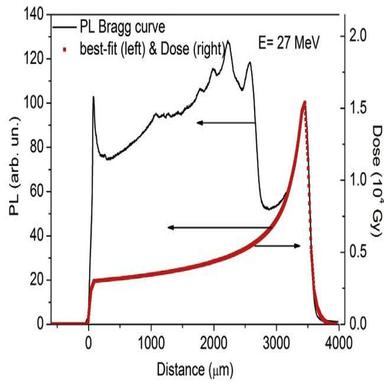
PL Bragg curve profile of the selected r.o.i. of with best fit and dose profile of the 27 MeV component obtained by the procedure described in the text.